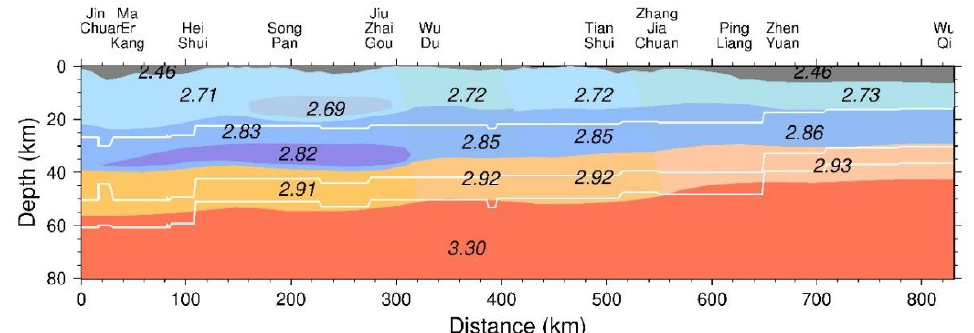
Figure 4. Crustal structure density model of gravity studies and Crust1.0 (the white lines represent upper crust, middle crust, and lower crust, respectively.) The numbers in the figure represent crust density (unit: g/cm 3 ). Crust1.0 model data from [31].